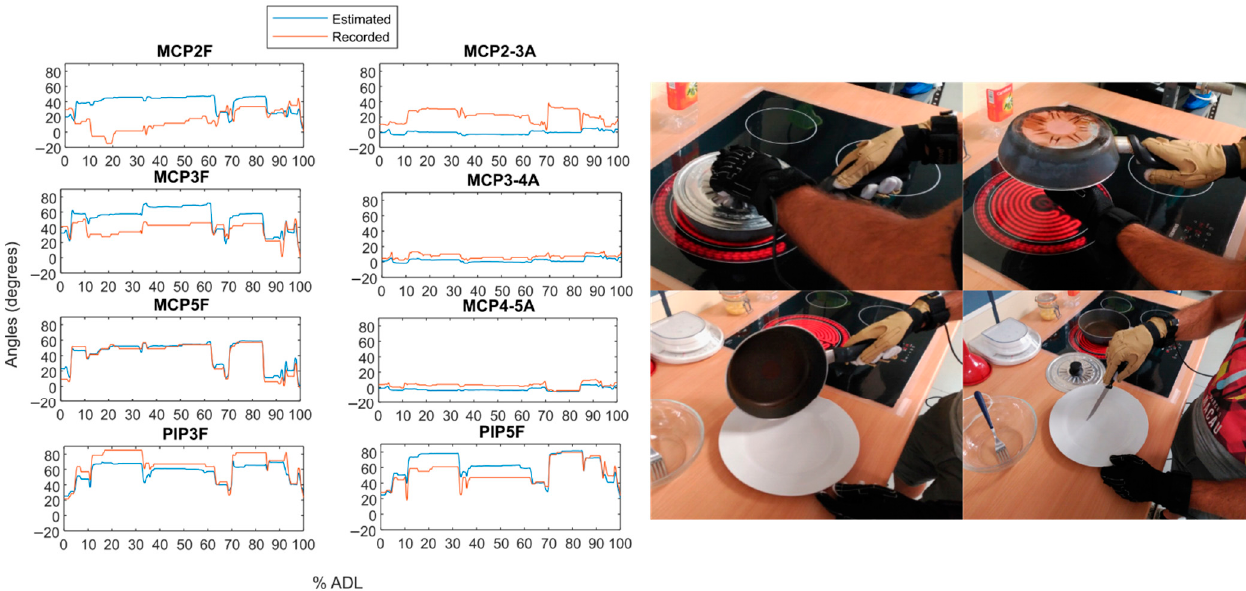
Figure 9. Estimated versus recorded angles for action 33 (“Cooking, serving and cutting a big omelette”). 1 to 5 refers to thumb to little fingers. F stands for flexion/extension and A for abduction/adduction movements.